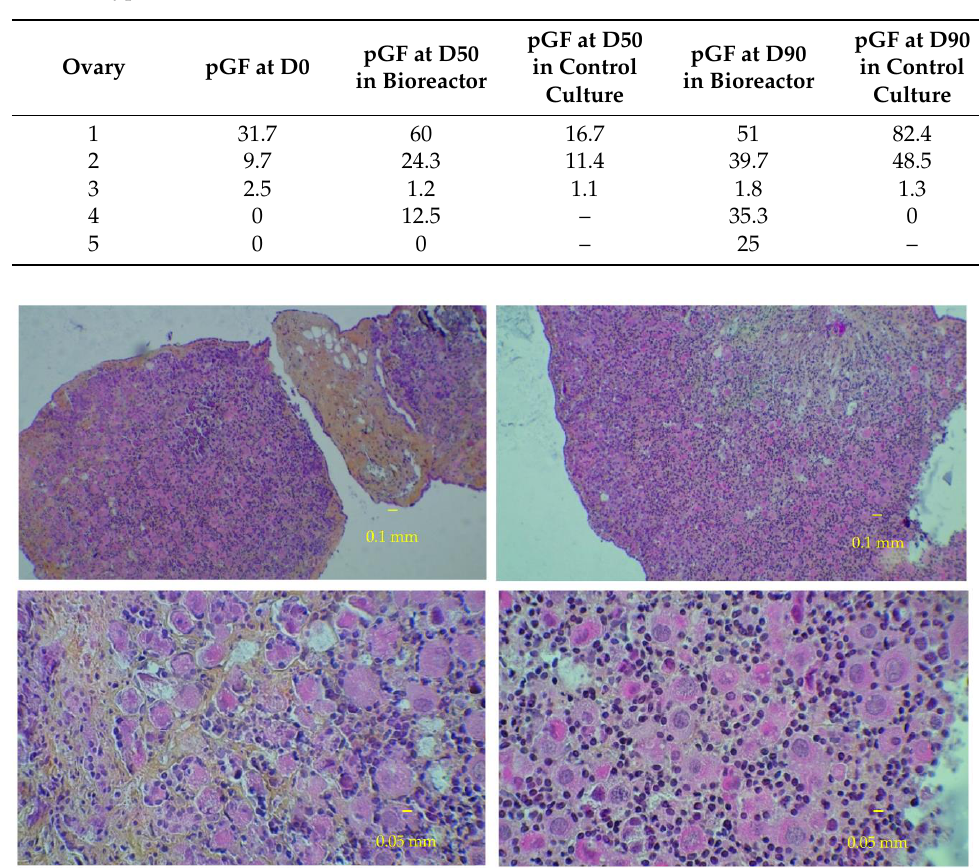
Figure 3. Fetal ovarian tissue in culture at day 50. Slices colored with hematoxylin-eosin-safran at low and high magnification. Left panels: control cultures. Right panels: bioreactor cultures.